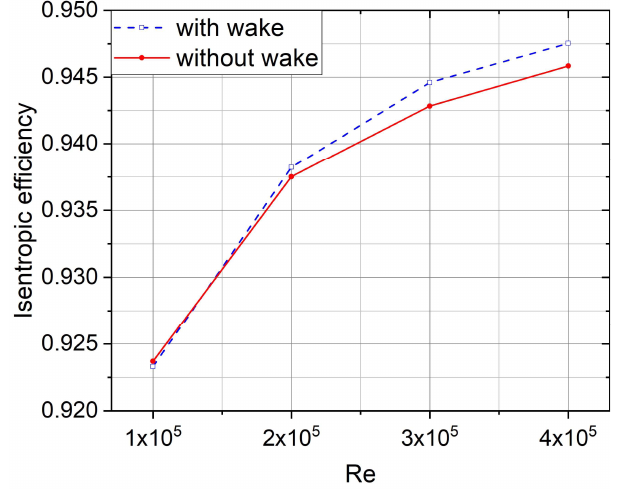
Figure 6. Isentropic efficiency distribution of the rotor at different Re.